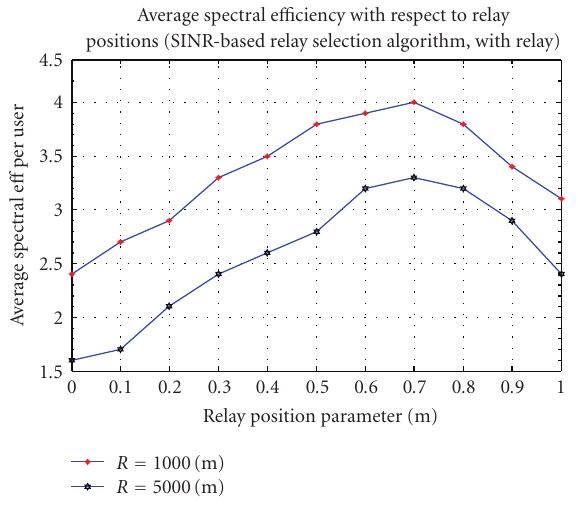
Figure 10: Relay position with respect to BS.